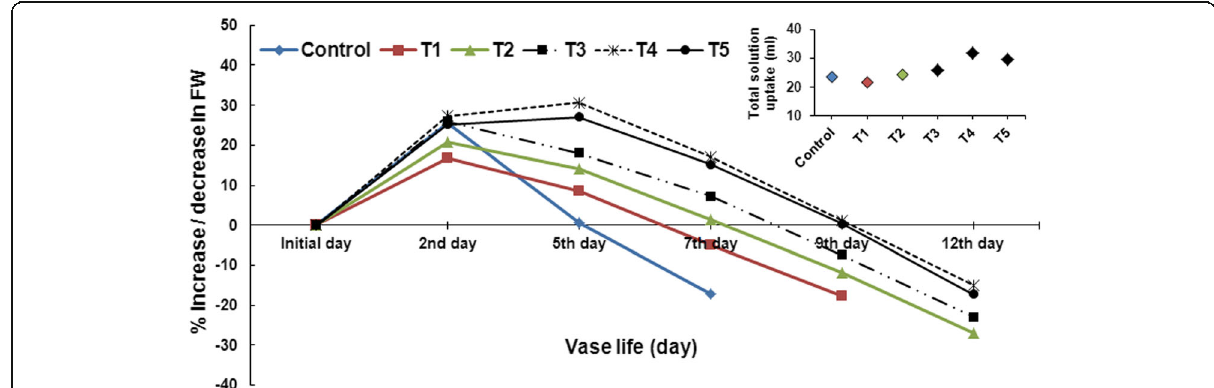
Fig. 3 Effect of different vase solutions (control, T 1 , T 2 , T 3 , T 4 , and T 5 ) on relative changes in fresh weight of gladiolus cut spikes. Inset represents total solution uptake (ml) during vase